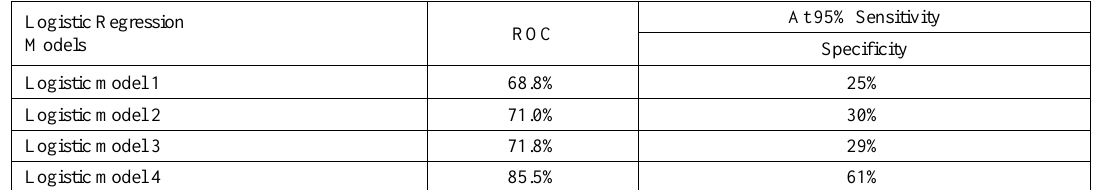
Table 2. ROC Areas for Logistic